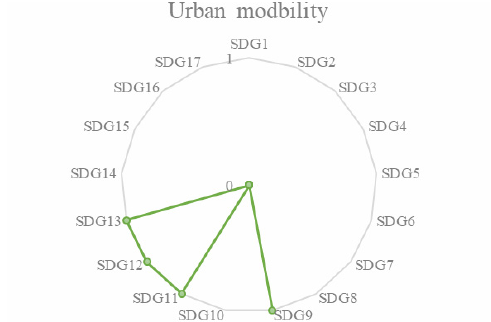
Figure 12. Urban modbility cluster of application effect on the SDGs